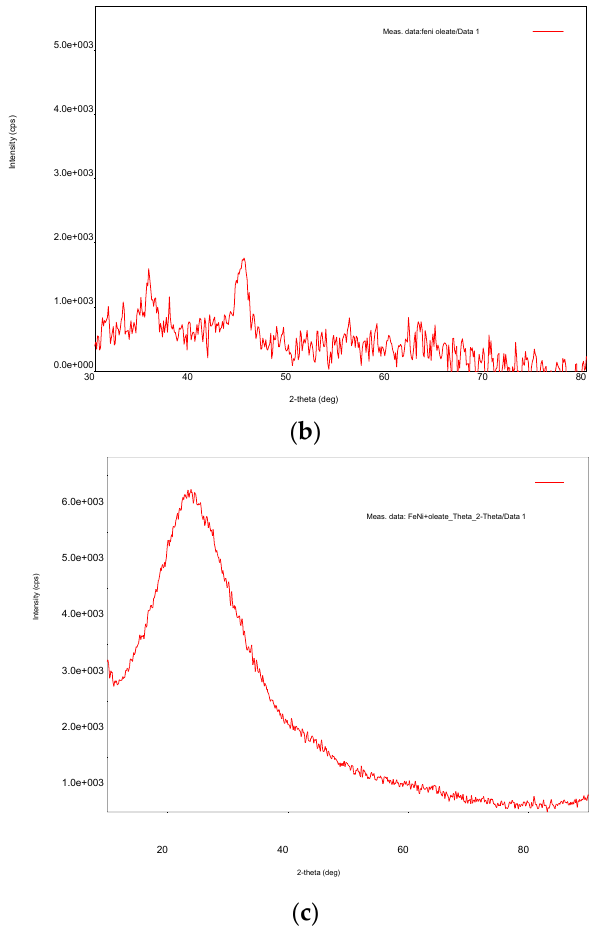
Figure 3. XRD of nZVI nanoparticles ( a ), 0.5% Ni loading Fe/Ni bimetallic nanoparticles without sodium oleate ( b ), and with sodium oleate ( c ).